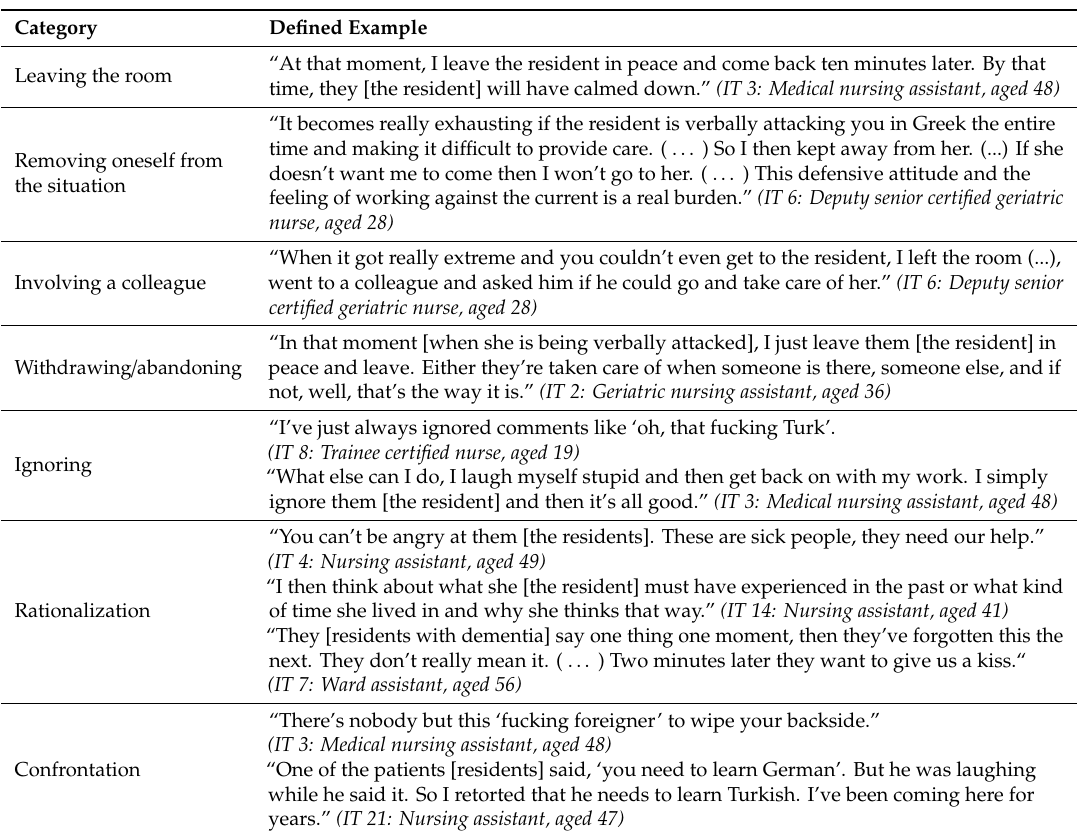
Table 4. Handling of discrimination (management